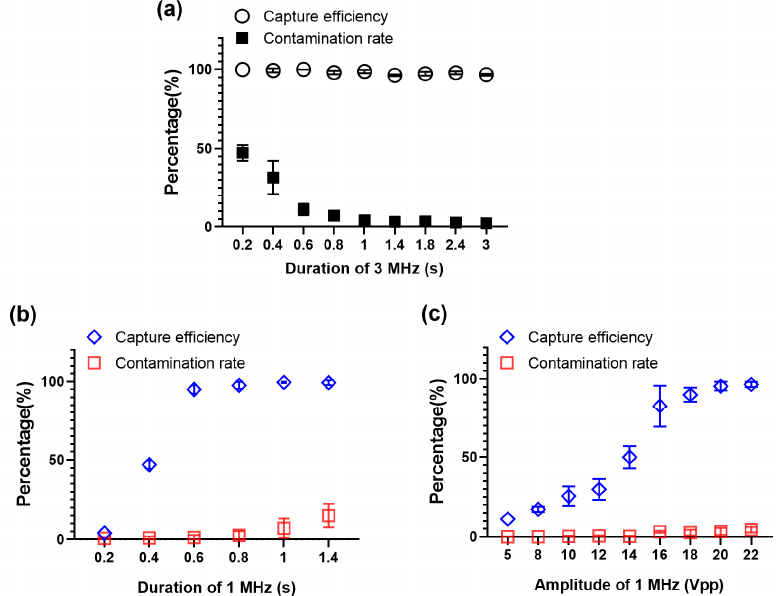
Figure 2. The capture efficiency and PBMCs contamination rate at different duration or amplitude of the 3 MHz or 1 MHz sine wave signal. ( a ) Percentages of MCF7 cells and PBMCs moved to the center of the microchannel at different duration of 3 MHz sine signal. ( b , c ) Percentages of MCF7 cells and PBMCs moved to the center of the microchannel at different duration ( b ) or amplitude ( c ) of the 1 MHz sine wave signal. In all figures, values are expressed by means and error bars.